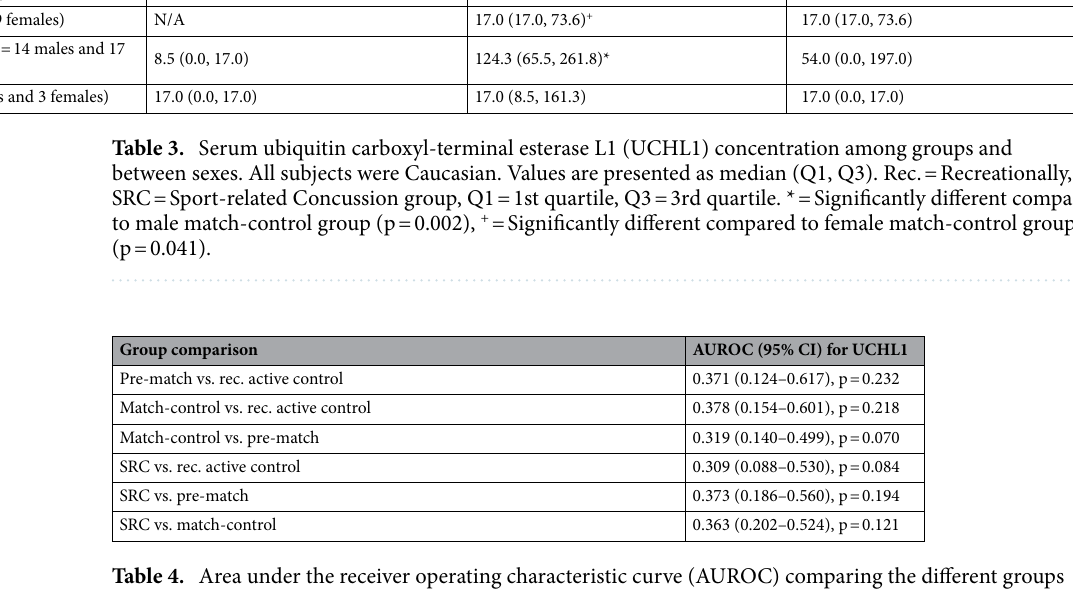
Group comparison AUROC (95% CI) for UCHL1 Pre-match vs. female